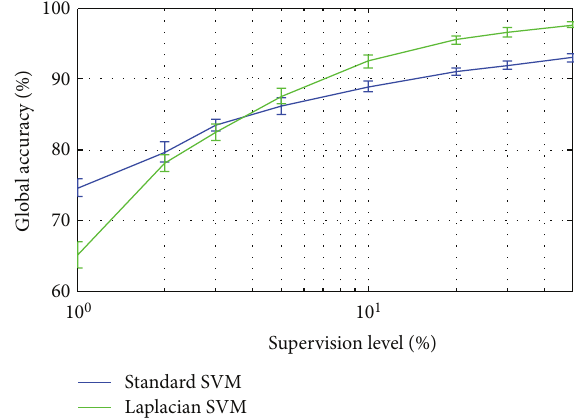
Figure 7: Effect of the filter size in temporal accumulation. Plot of the accuracy as a function of the TA filter size. (IDOL2 dataset, SPH Level 3 features).